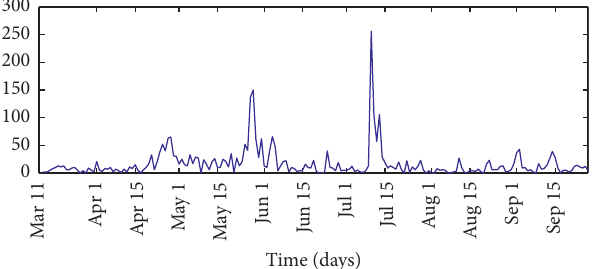
Figure 4: Daily reported COVID-19 cases from 11 th March 2020 to 29 th September 2020, Sri Lanka (source: Epidemiology Unit, Ministry of Health, Sri Lanka).